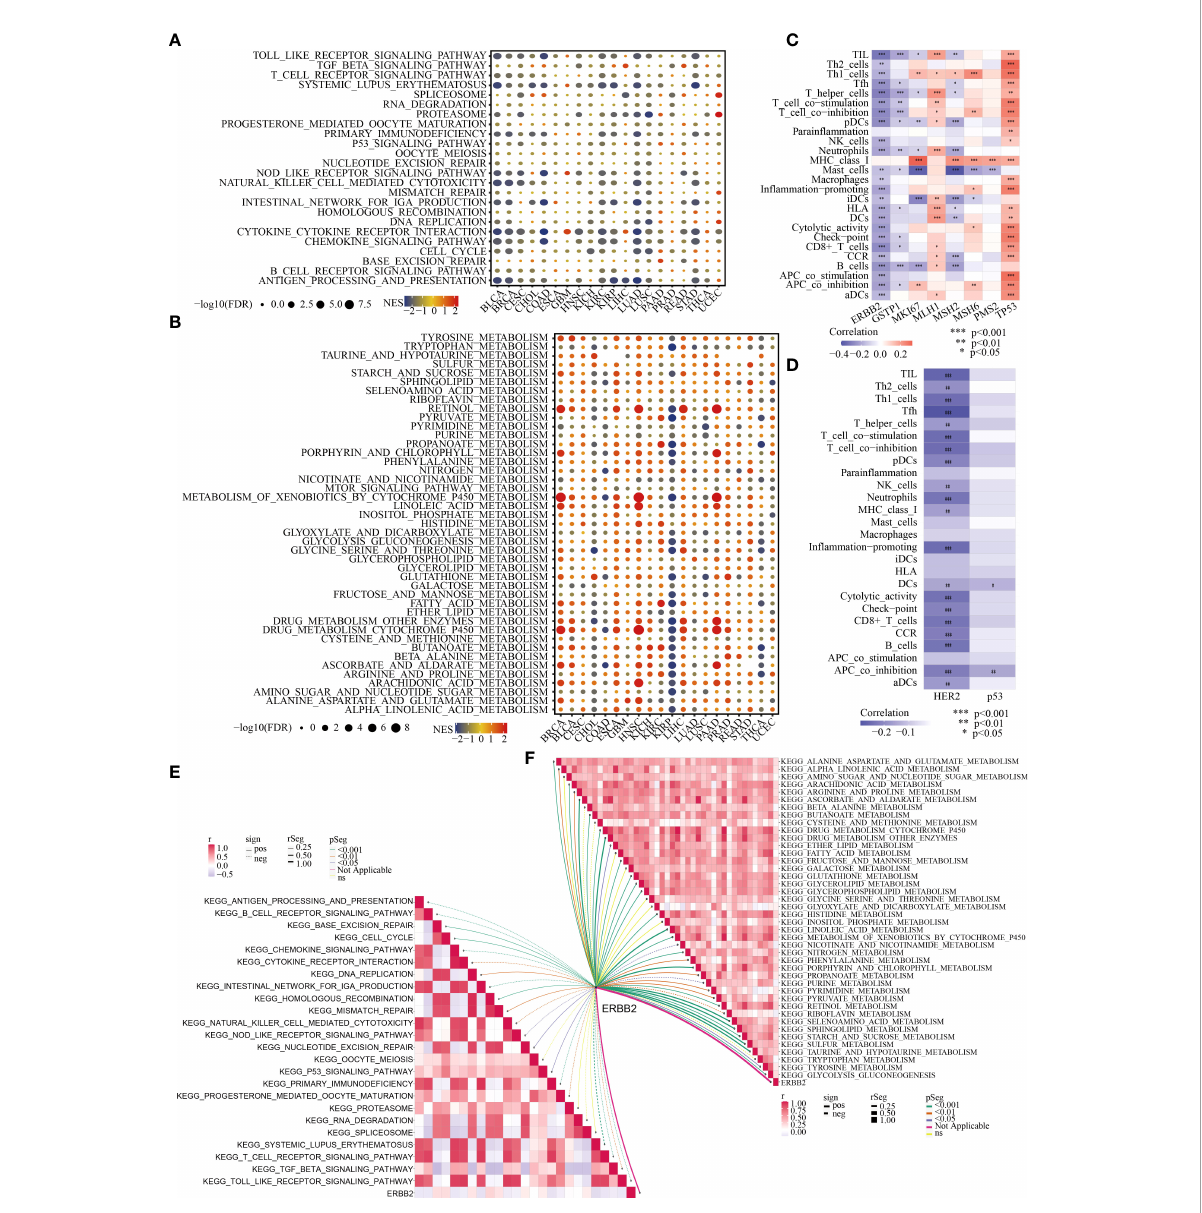
FIGURE 2 Association of ERBB2/HER2 with the immune microenvironment and metabolic remodelling in pan-cancer (especially in GC). Enrichment analysis for immune (A) and metabolic (B) pathways between tumour tissues with high and low ERBB2 expression; NES is the normalised enrichment score in the GSEA algorithm. ssGSEA highlights the regulatory role of ERBB2 (C) and HER2 (D) in the immune microenvironment of GC based on TCGA-STAD and TCPA-STAD cohorts. The correlation between ERBB2 and immune (E) and metabolic (F) pathways in GC was